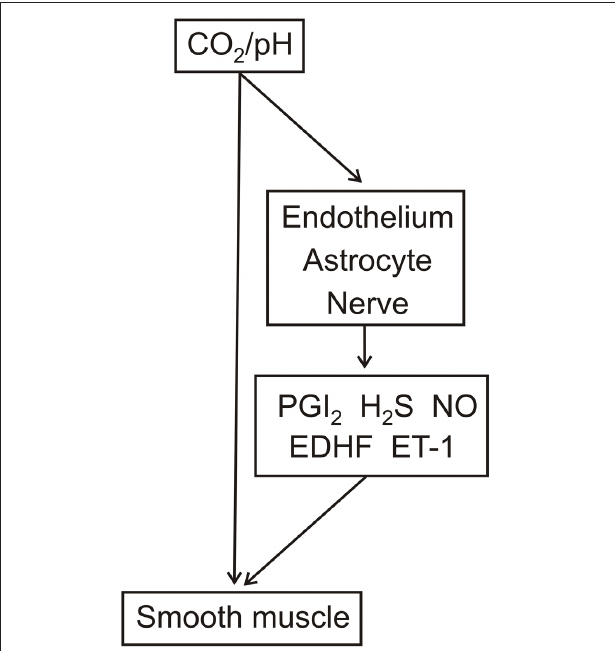
FIGURE 2 | Potential cellular sites of action and vasoactive factor involvement in respiratory hypercapnia/hypocapnia-mediated relaxation/contraction. The effects of respiratory hypercapnia/hypocapnia may be mediated through accompanying changes in pH and/or directly by pCO 2 . pH and/or pCO 2 act on the smooth muscle as well as on the endothelium, nerves, and astrocytes. These latter cell types release vasoactive factors, including PGI 2 , H 2 S, NO, endothelium-derived hyperpolarizing factor (EDHF), and endothelin-1